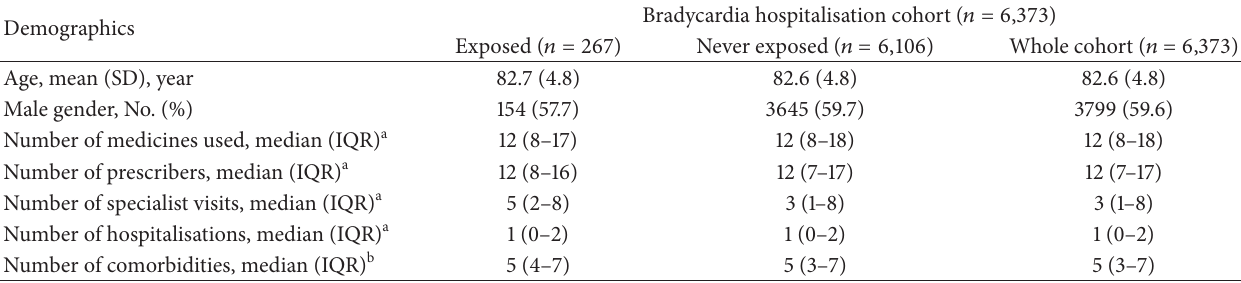
Table 1: Demographics of the study cohort.